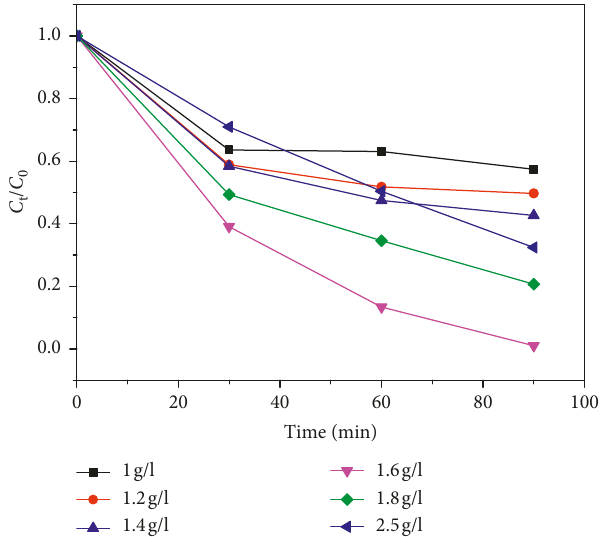
Figure 9: Optimization of catalyst load in the degradation of RhB by Fe-C-TiO 2 /AC.